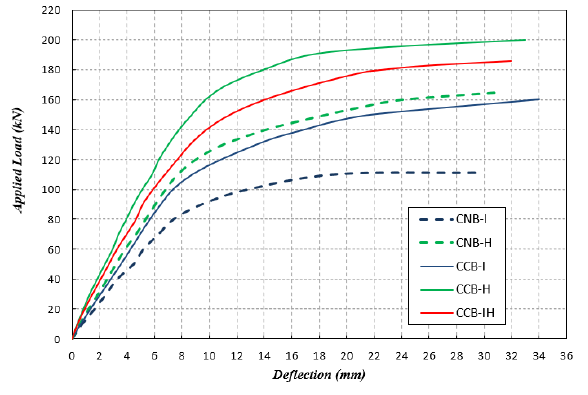
Figure 18: Load-deflection curves of all